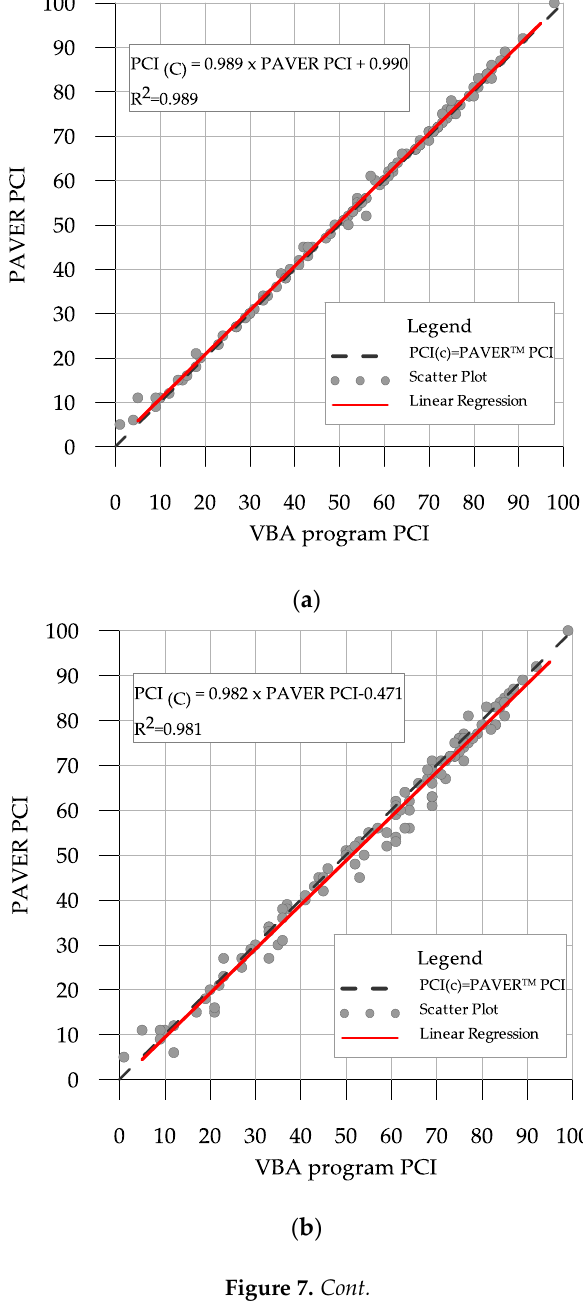
Figure 7. Cont . Figure 7.